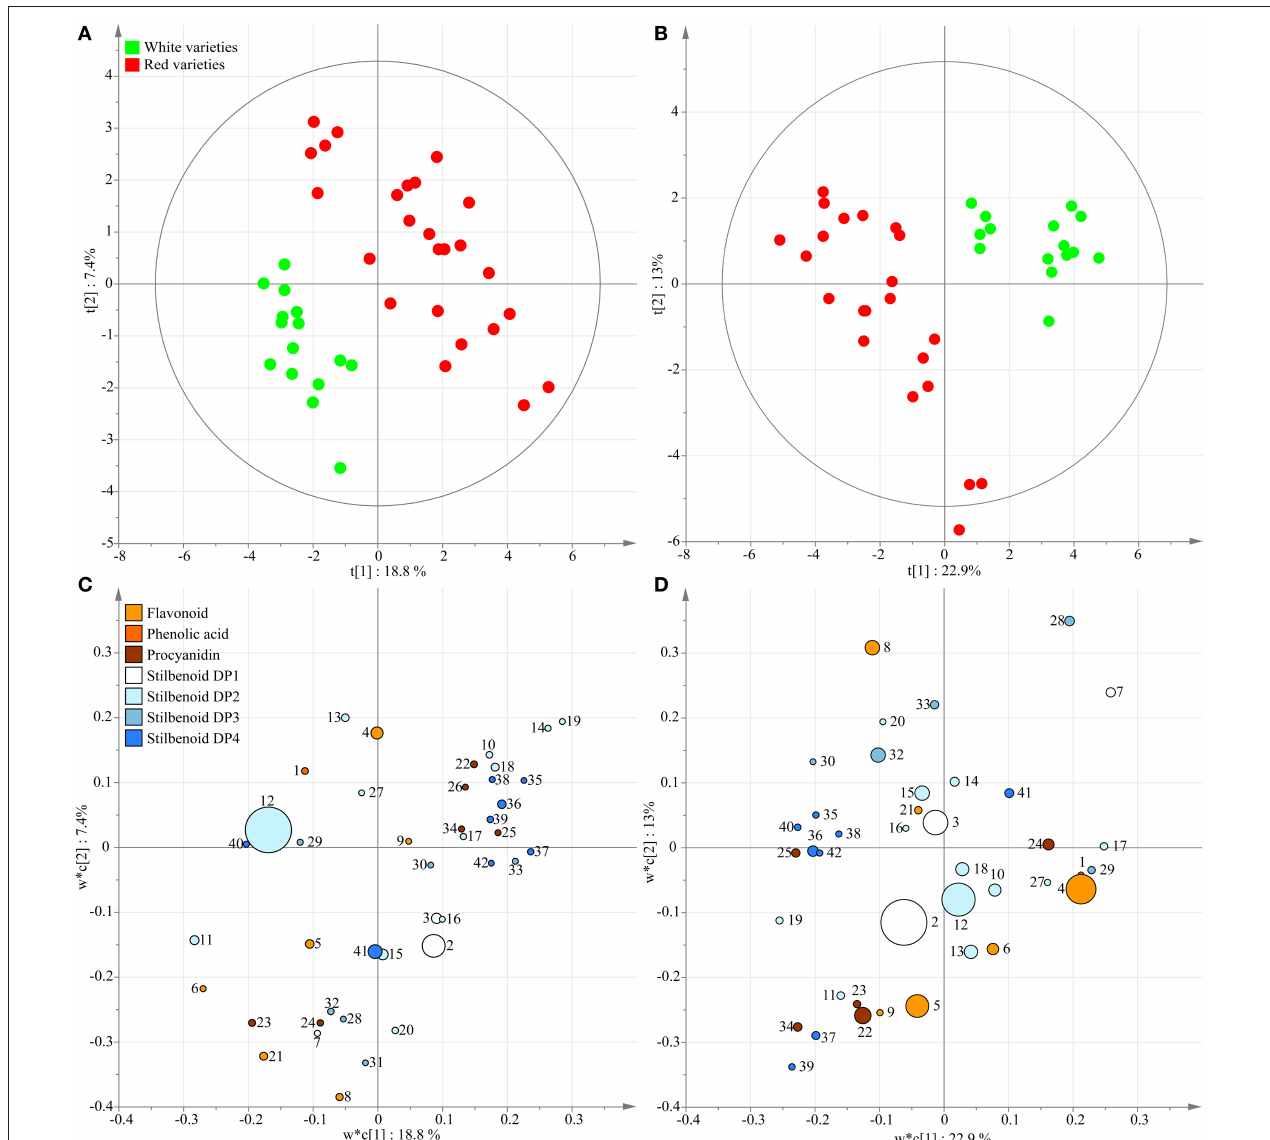
FIGURE 4 | Supervised classification using PLS-DA with “cultivar color” as dependent variable on polyphenol data from grape stems of eight genotypes in 2013 (A,C) and 2017 (B,D) . Variables in score plots (A,B) were colored according to cultivar color. Variables in the loading plots, (C,D) were colored according to polyphenol class with round size relative to the abundance of the selected ion. Numbers indicate the ID of the compounds as given in Table 2